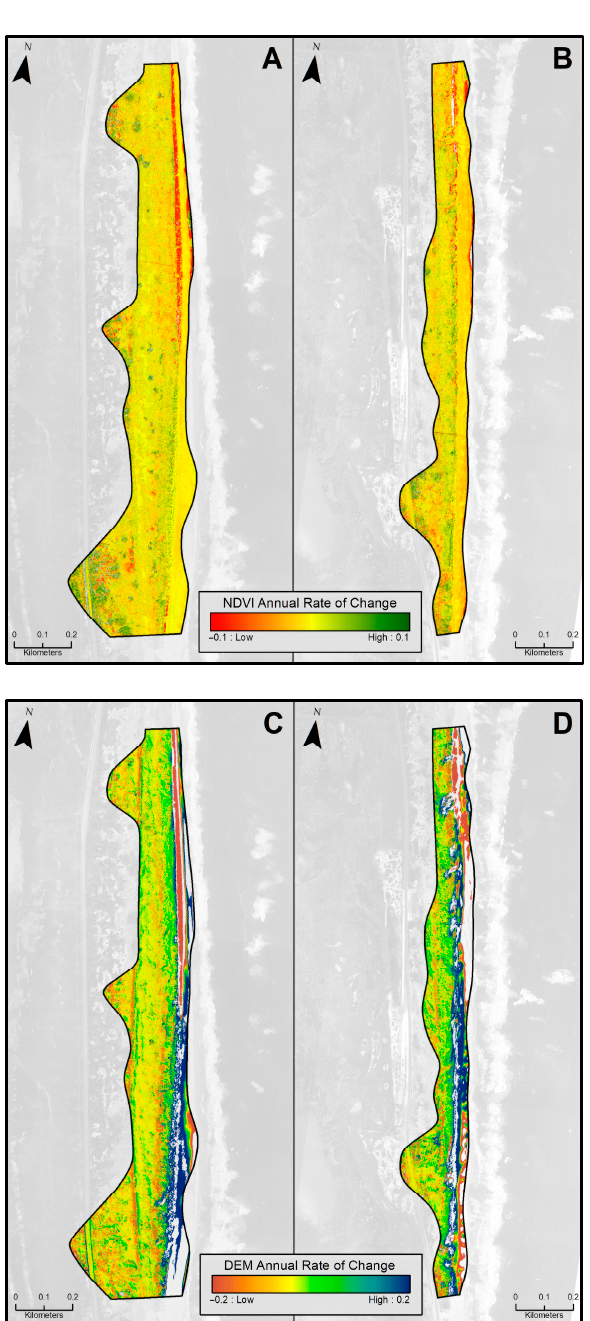
Figure 4. Elevation and normalized difference vegetation index regression (per-pixel rate of change from 2016 to 2019) within the Pea Island North ( A , C ) and Pea Island South ( B , D ) assessment